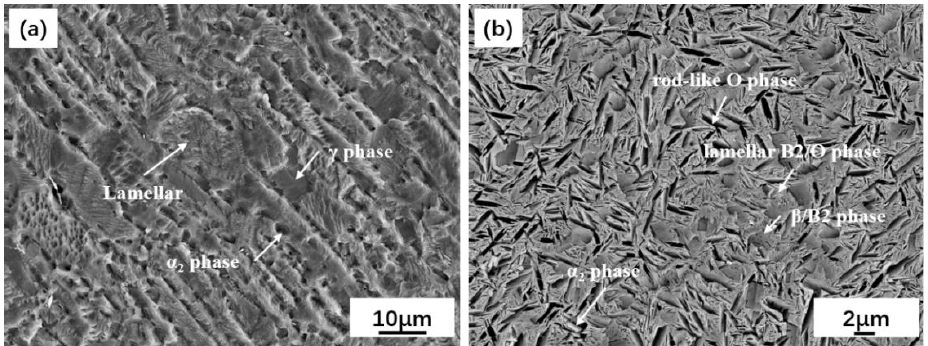
Figure 1. Microstructure of the test parent material: ( a ) TiAl; ( b ) Ti 2 AlNb. Table 1. Chemical composition of TiAl and Ti 2 AlNb (wt.%).